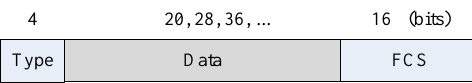
Figure 5. The structure of the insertion ACK frame.